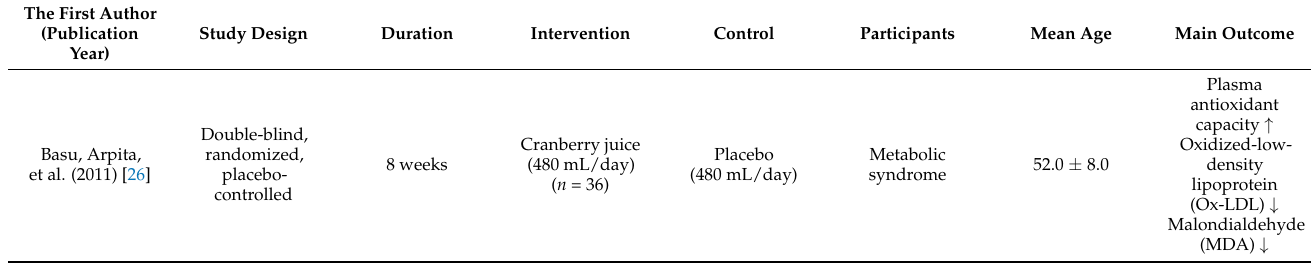
Table 3. Biological activities of red-colored food-derived